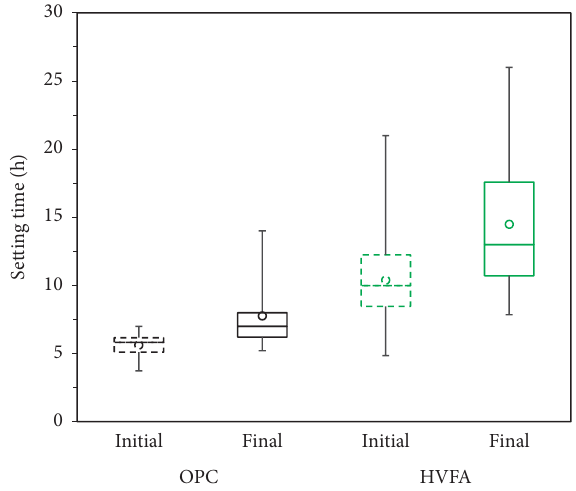
Figure 3: Comparison of setting times between OPC and HVFA mixtures, based on data collected from relevant studies.